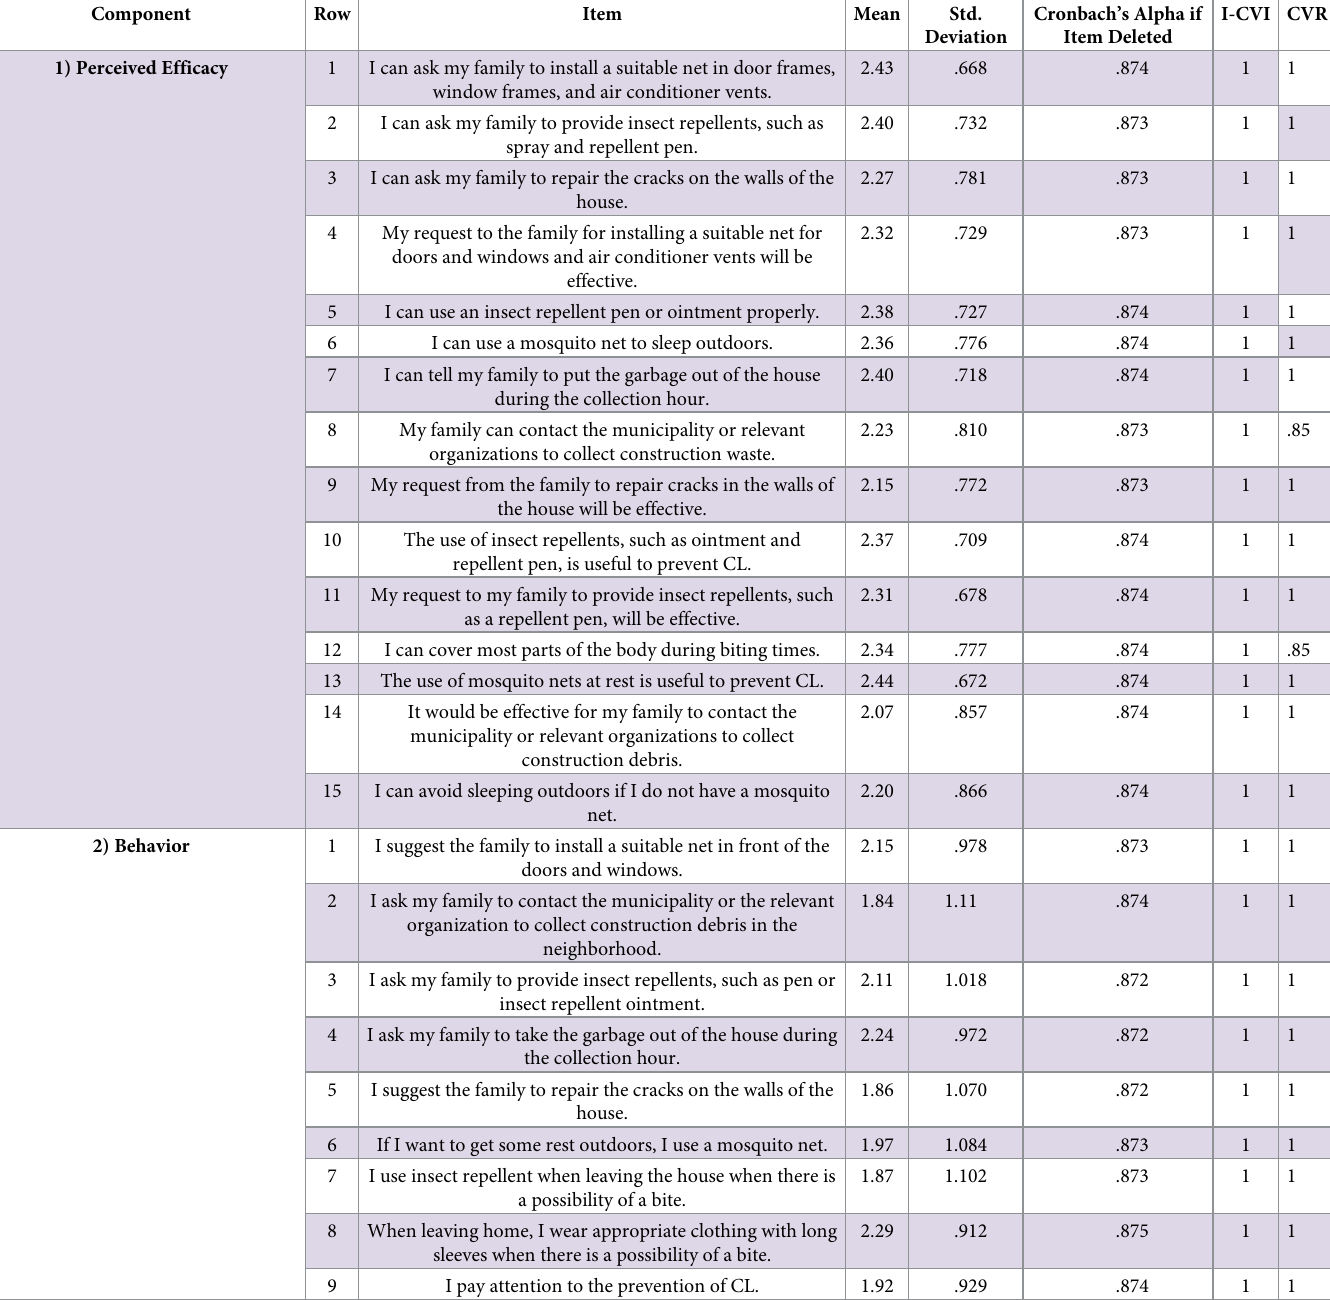
Table 1. Items of the questionnaire of the CL preventive behaviors and factors related to the integration of PEN-3 and EPPM with mean, Std. Deviation, CVR, and CVI. Component Row Item Mean Std.